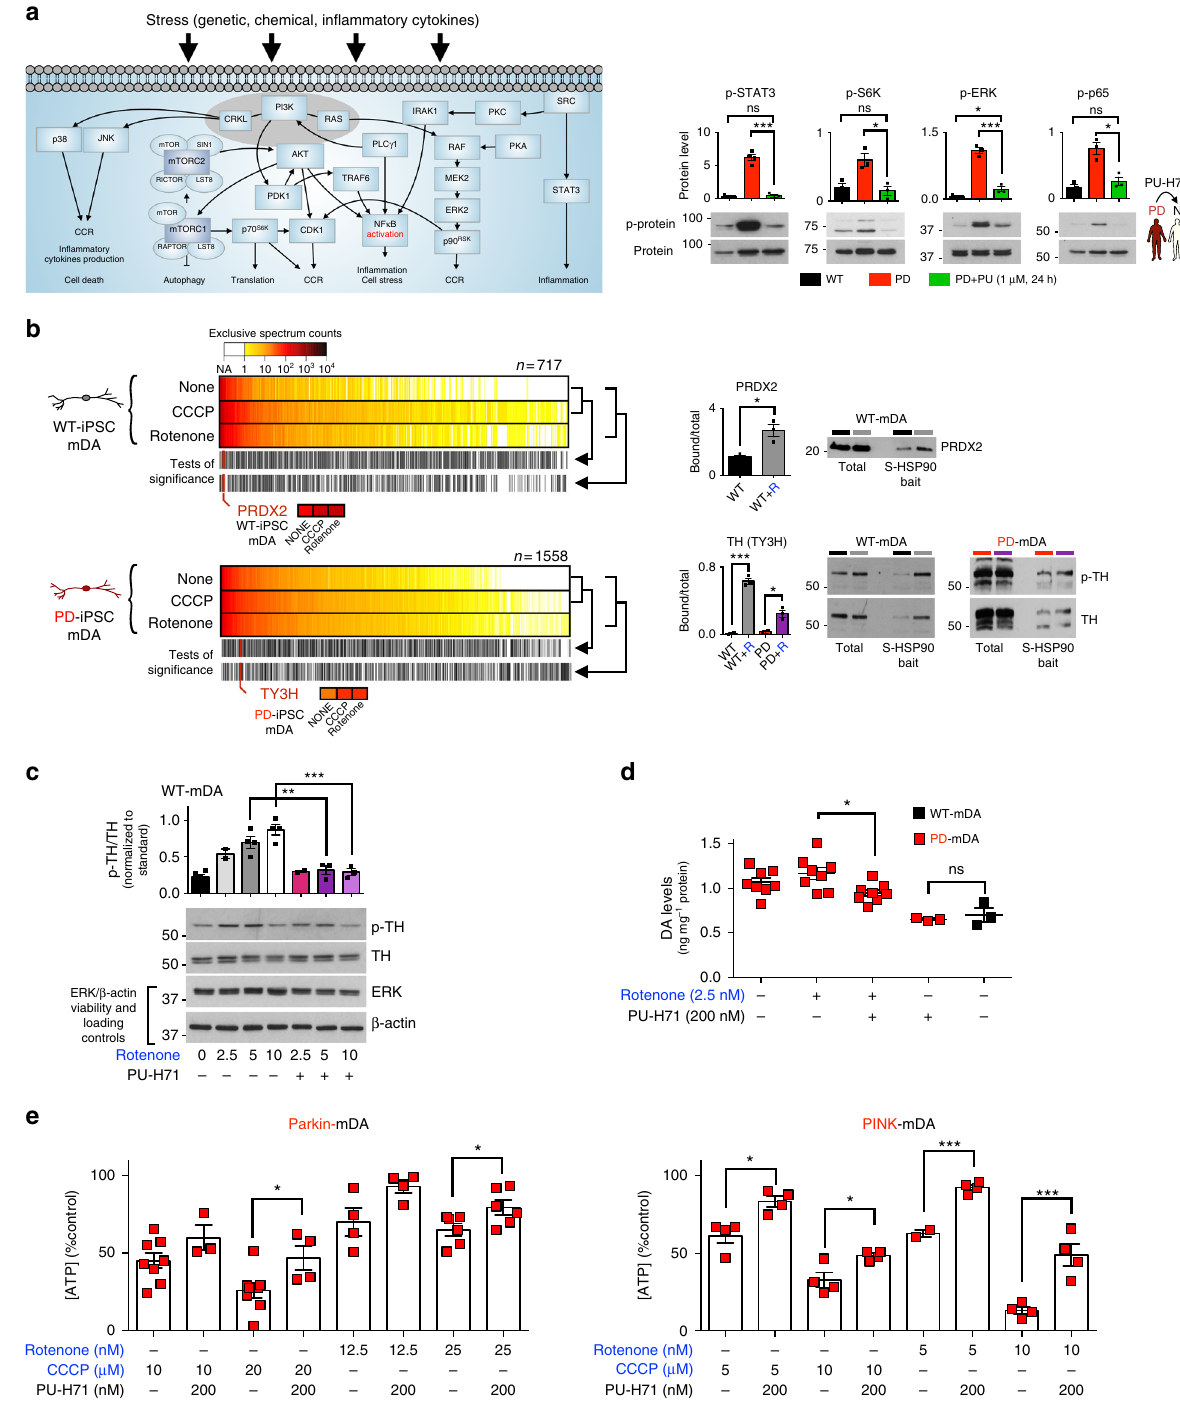
Fig. 5 Validation of protein alterations and functional studies for pathways induced by genetic and toxic stress, and reversal of PD-related alterations following S-HSP90 inhibition. a Schematic illustration of key signaling proteins and pathways activated in response to genetic stress. Western blot con fi rms higher activity of these pathways in PD over WT mDA neurons, and shows that PU-H71 restores these to WT levels. Mean± SEM, n = 3 individual values from the different experiments shown as points, t -test, *** p < 0.001; ** p < 0.01; * p <0.05; ns p > 0.05. b Heatmaps of proteins signi fi cantly enriched under toxic stress (10 µ M CCCP; 20nM rotenone) and their validation by western blot (Input, total levels and S-HSP90 bait isolate, chaperome network associated). Mean ±SEM, n = 3 individual values from the different experiments shown as points, t -test, *** p < 0.001; * p < 0.05. c Western blot and quanti fi cation of rotenone stress increase in the p-TH:TH ratio and its reduction by PU-H71 (200 nM). p-ERK/ERK, cell viability control; β -actin, protein loading control. Mean ±SEM, n = 3 individual values from the different experiments shown as points, One-way ANOVA with Tukey ’ s post-hoc, *** p < 0.001; ** p < 0.01. d Total intracellular dopamine levels in PD mDA neurons in conditions of toxic stress and under PU-H71 rescue; Mean± SEM, n = 4 – 5 individual values from the different experiments shown as points, t -test, * p < 0.05. e PU-H71 treatment of rotenone- or CCCP-stressed mDA neurons signi fi cantly increases their viability, as measured by total ATP levels; means± SEM, n = 3 – 8 from independent differentiations, t -test, *** p < 0.001; ** p < 0.01; * p <